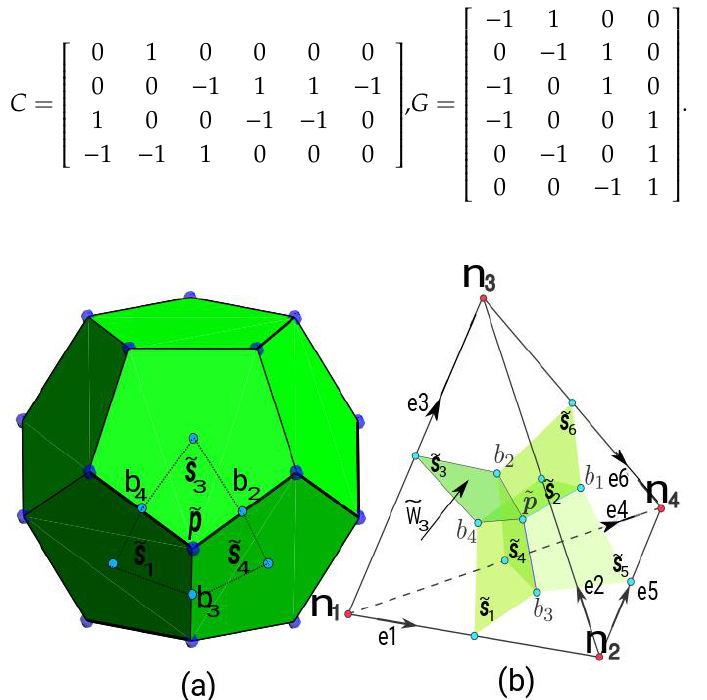
Figure 3. ( a ) Dual volume 𝑉̃ and nodes of the dual volume in blue; ( b ) Primal volume V , primal nodes n in red with oriented primal edges e , and dual planes 𝑆̃ in green.